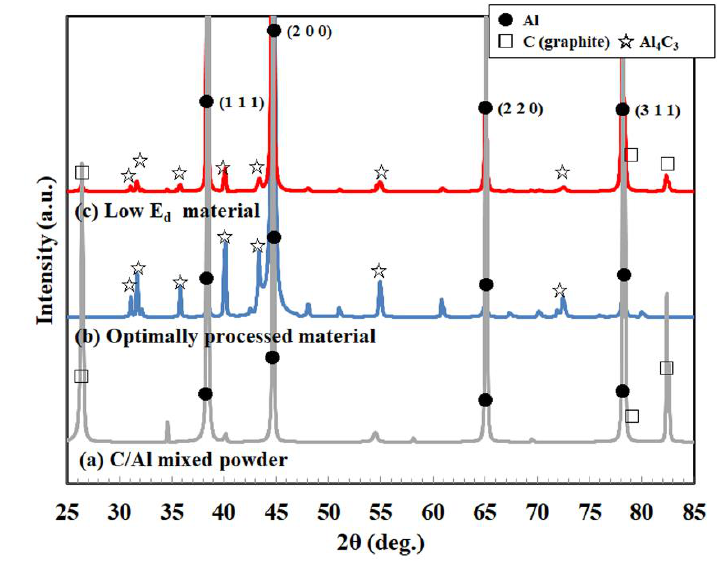
Figure 8. XRD patterns of ( a ) C/Al mixed powder, ( b ) optimally processed material, and ( c ) low energy density material.